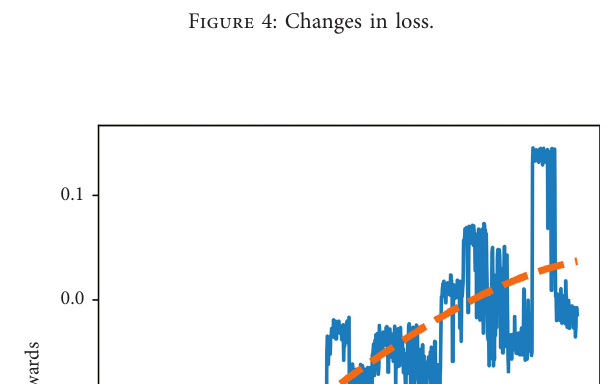
Figure 4: Changes in loss.